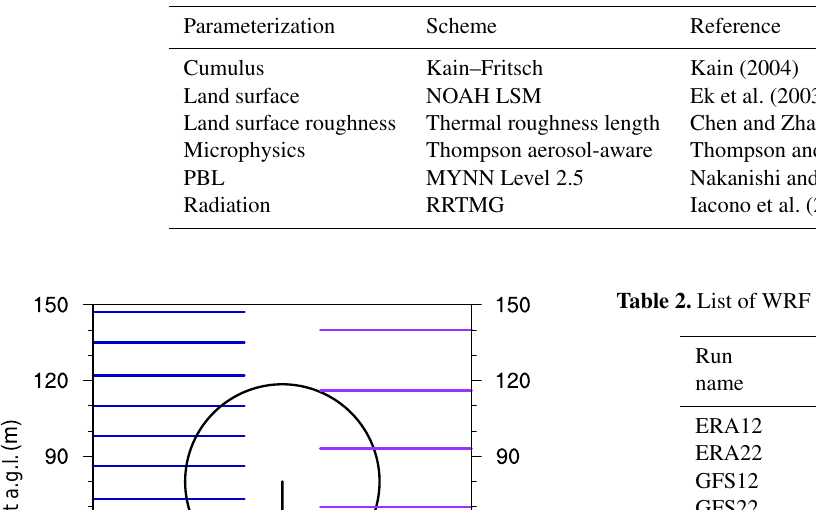
Table 1. The WRF model configuration.